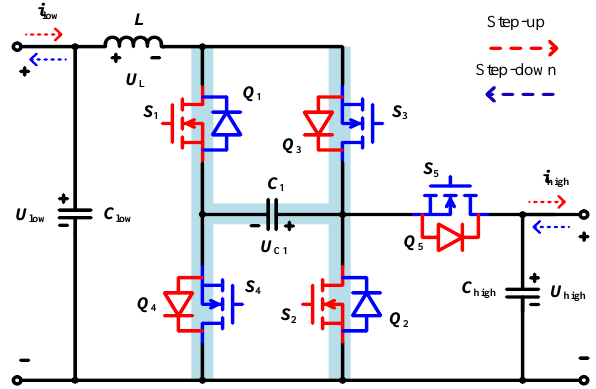
Figure 2. Configuration of the proposed converter.